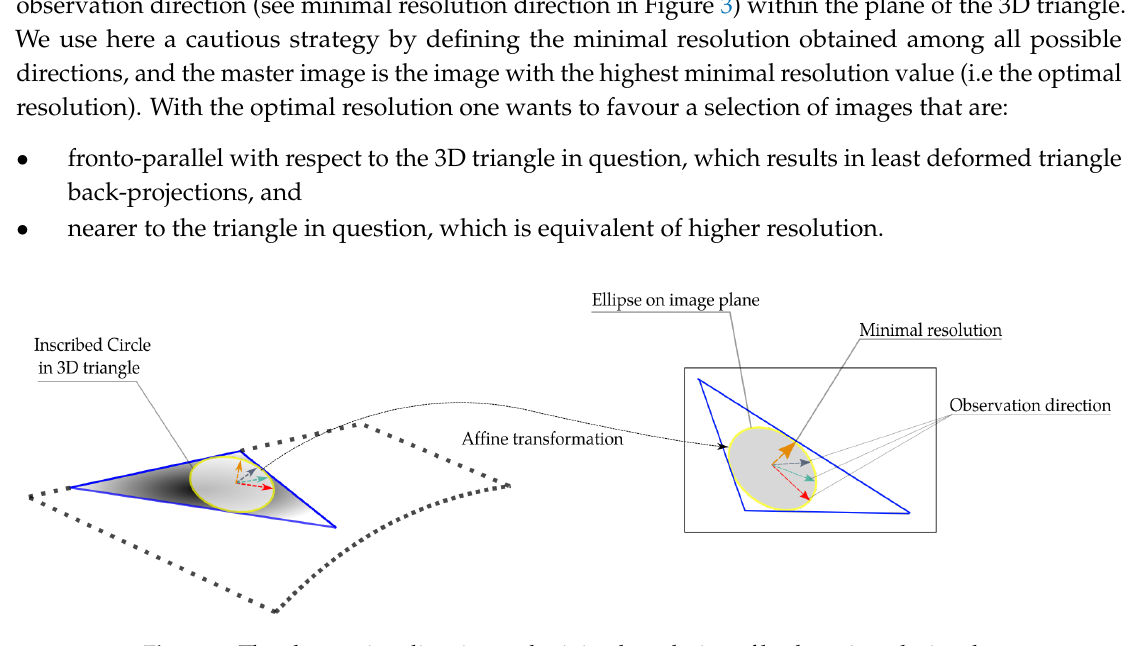
Figure 3. The observation direction and minimal resolution of back-projected